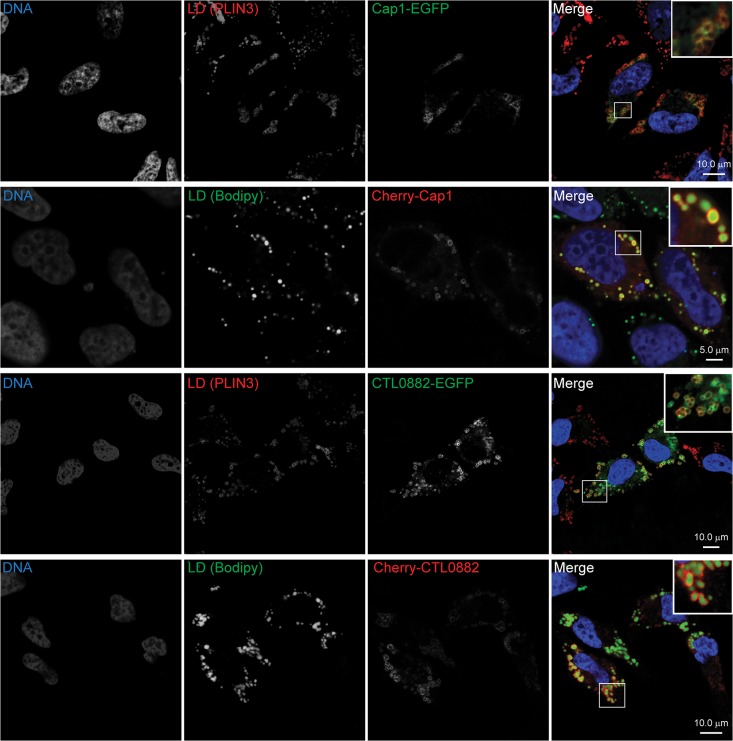

C. trachomatis inclusion membrane proteins Cap1 and CTL0882 co-localize with LDs.Representative confocal images of HeLa cells transfected with constructs encoding Cap1 or CTL0882 C-terminally fused to EGFP or N-terminally fused to Cherry, stimulated with oleic acid 200 μM for 8 h prior to fixation. LD labeling was done by either immunostaining of the LD structural protein PLIN3 (red channel) or by neutral lipid staining with BODIPY 493/503 (green channel). Hoechst staining was used to visualize DNA (blue). Bar sizes are shown in the merge panels.